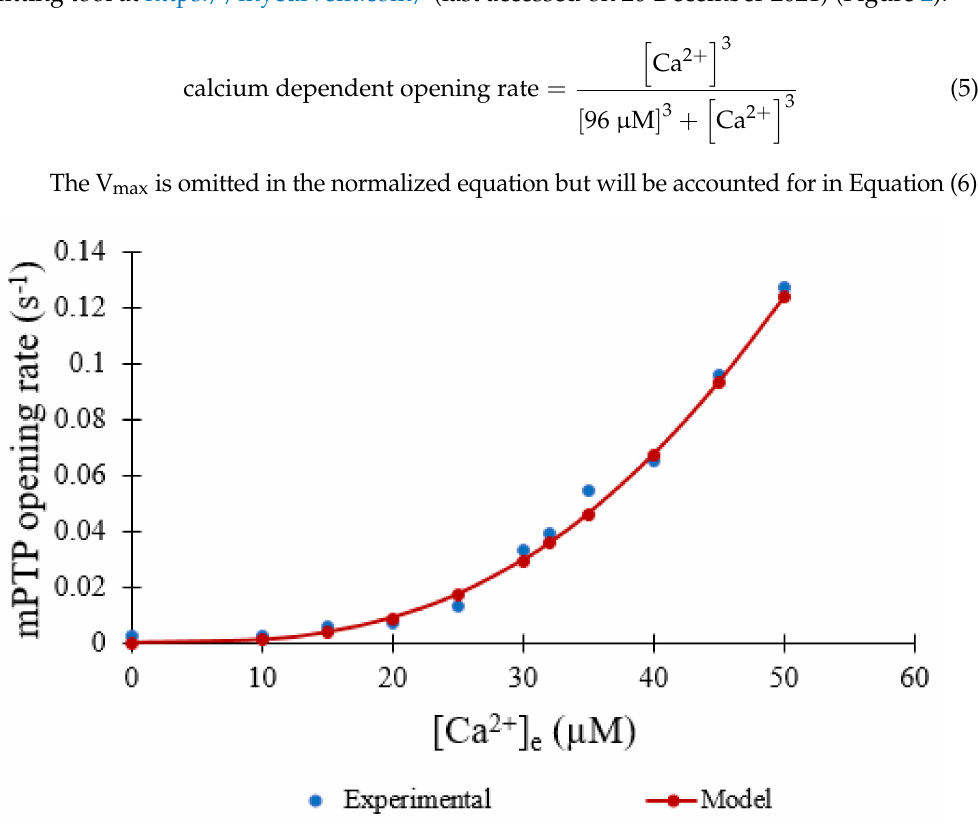
Figure 2. Calcium dependence of mPTP opening based on the assumption that the normalized rate of mPTP opening is linearly proportional to the rate of experimentally measured volume change (blue) [9]. Model fit to data